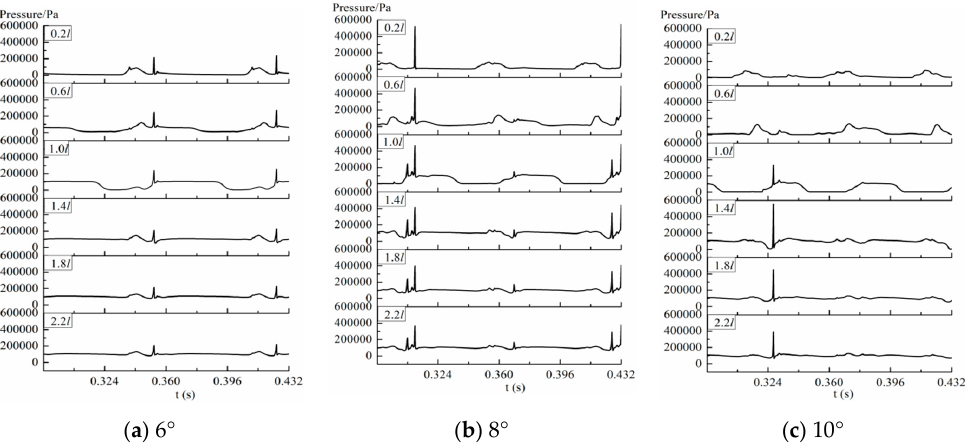
Figure 10. Pressure fluctuation curve of each monitoring point under different attack angles in two periods. in two